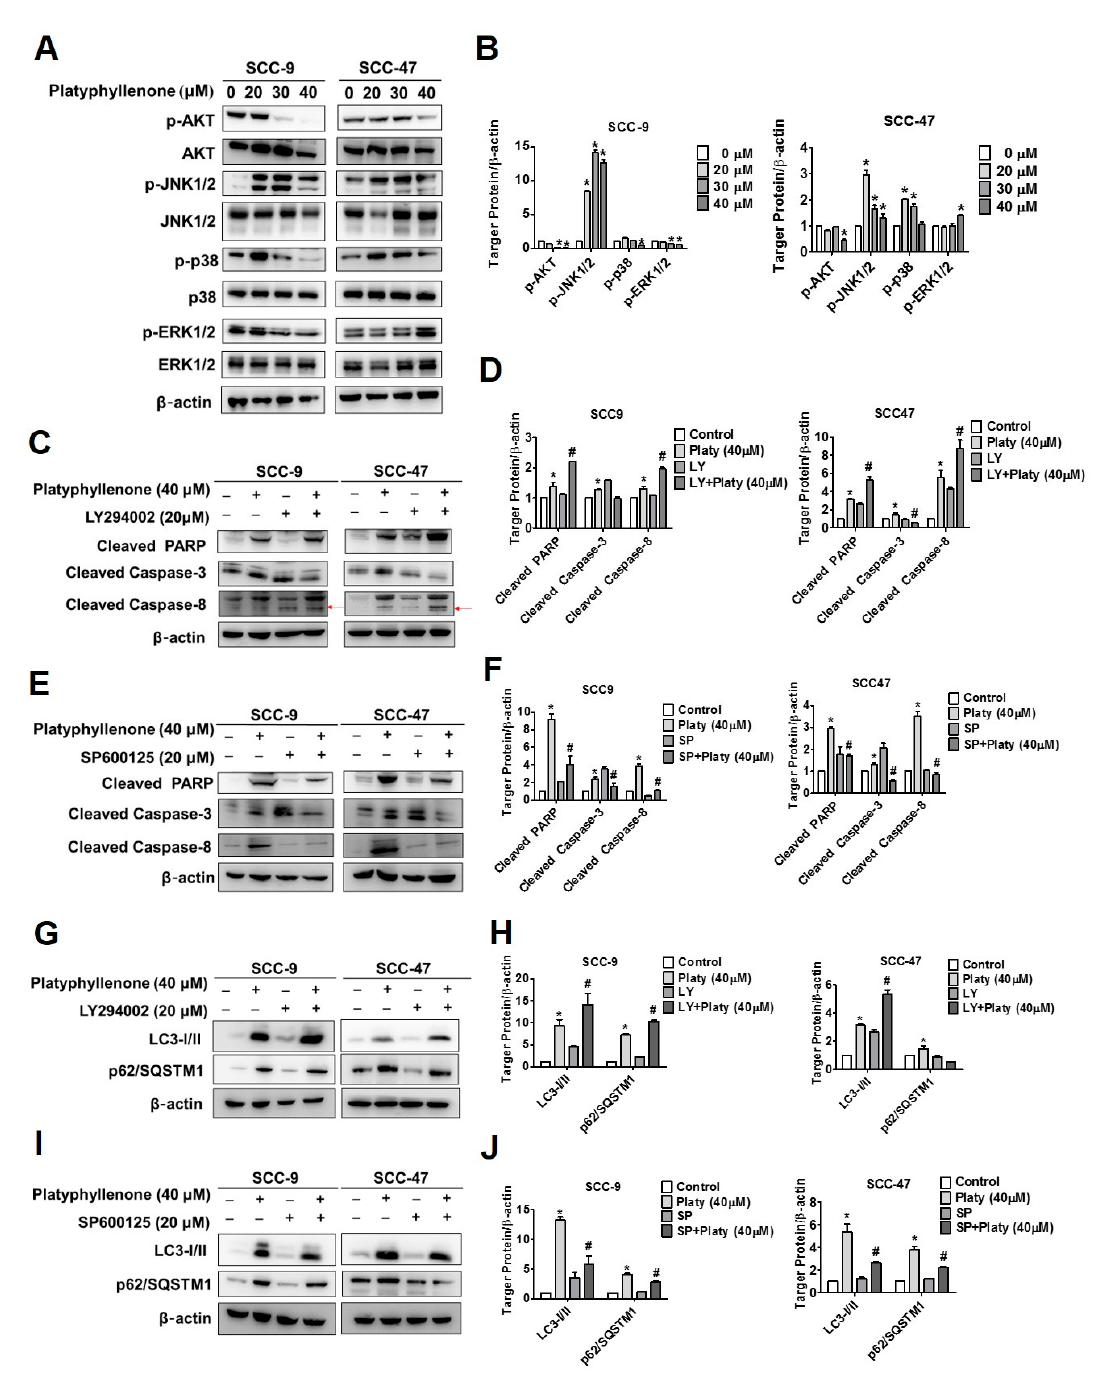
Figure 6. The induction of apoptosis and autophagy by platyphyllenone is dependent on the regulation of AKT and JNK signaling pathways in SCC-9 and SCC-47 oral cancer cells. “+”, treat; “ − ”, non-treat. ( A , B ) After treatment with platyphyllenone on SCC-9 and SCC-47 cells, Western blotting was used to detect the protein expression of p-AKT, p-JNK1/2, p-p38, p-ERK1/2, and the results of both cells were quantified. ( C – J ) SCC-9 and SCC-47 cells were pretreated with LY294002 or SP600125 for 1 h and then incubated in the presence or absence of 40 µ M platyphyllenone for 24 h. Western blotting was then used to detect the protein expression of apoptosis ( C – F ) and autophagy ( G – J ) related proteins and quantify results. All quantitative results are given for each protein expression after being adjusted with β -actin. The values represent the means ± SD of at least three independent experiments. Student’s t test was applied to determine statistical significance, and two-tailed p values are shown (* represents p < 0.05; # represents p <